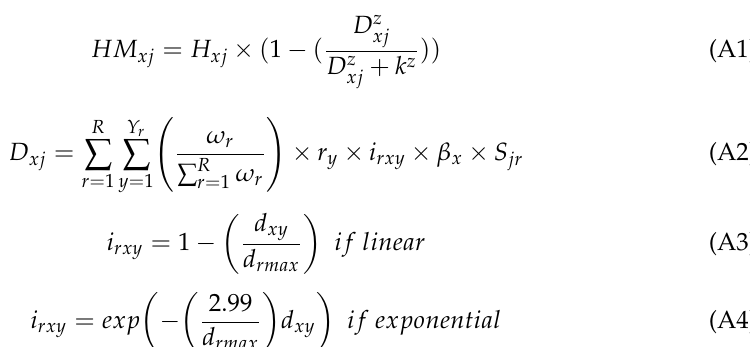
Figure A3. Number ( a ) and area ( b ) of ecological sources under different area thresholds in 2020.